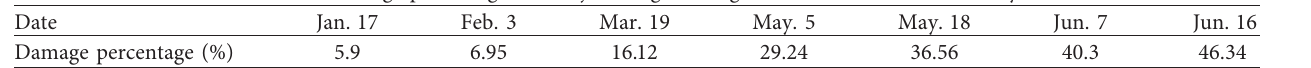
Figure 11: Acceleration data recorded by sensor number 2 on (a) January 17 and (b) June 16, 2008. Table 5: Damage percentage in Tianjin Yonghe Bridge on the seven considered